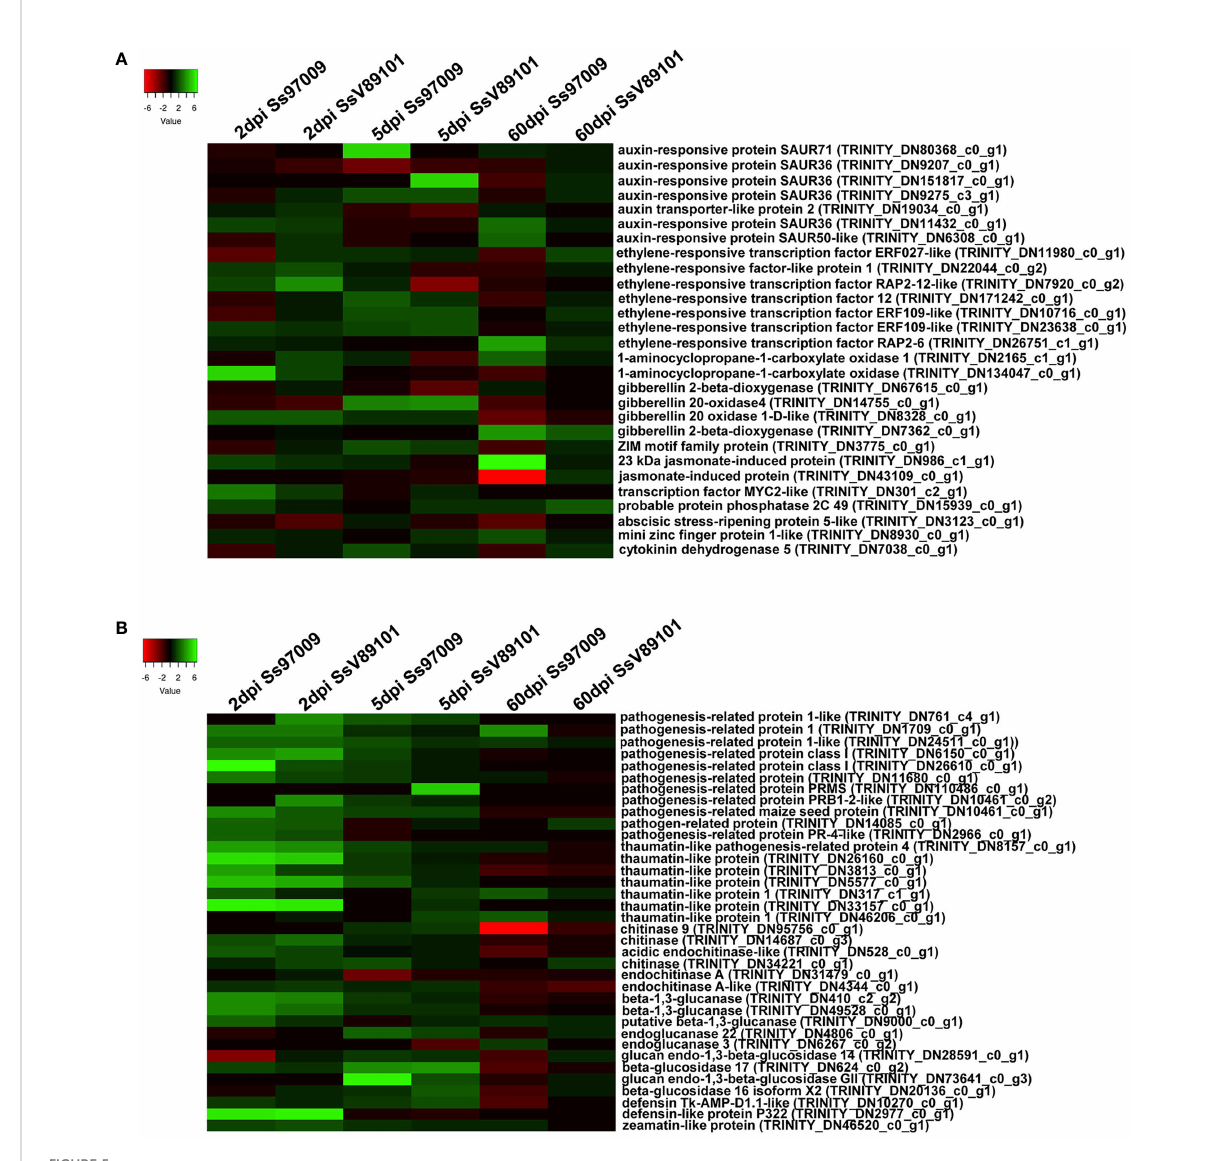
FIGURE 5 Heatmap of the differentially expressed genes (DEGs) in sugarcane cultivar Co 97009 inoculated with the S. scitamineum isolates Ss97009 and SsV89101. (A) DEGs related to hormone biosynthesis and (B) pathogenesis-related proteins with both the isolates at different time intervals (2 dpi, 5 dpi, and 60 dpi). Heatmaps were constructed using the log2 fold change values, and the genes in green and red represent up- and down- regulated genes